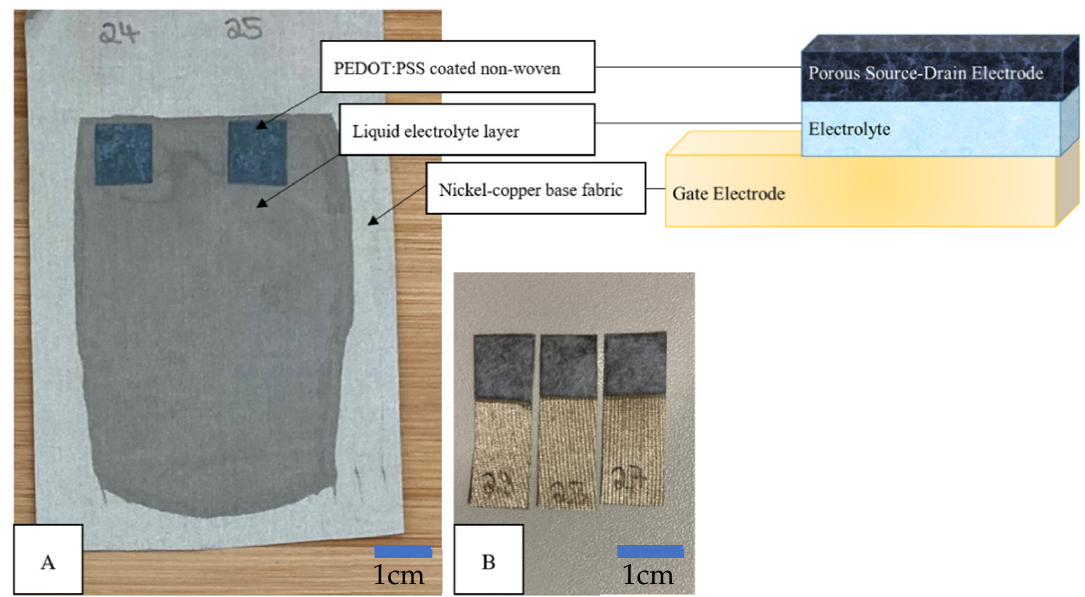
Figure 1. OECT Assembly. ( A ) Coating and assembling of nickel–copper base fabric with electrolyte solution and PEDOT:PSS-coated nonwoven. ( B ) Final OECT composed of the nickel–copper base fabric, hardened electrolyte layer, and PEDOT:PSS coated nonwoven fabric.